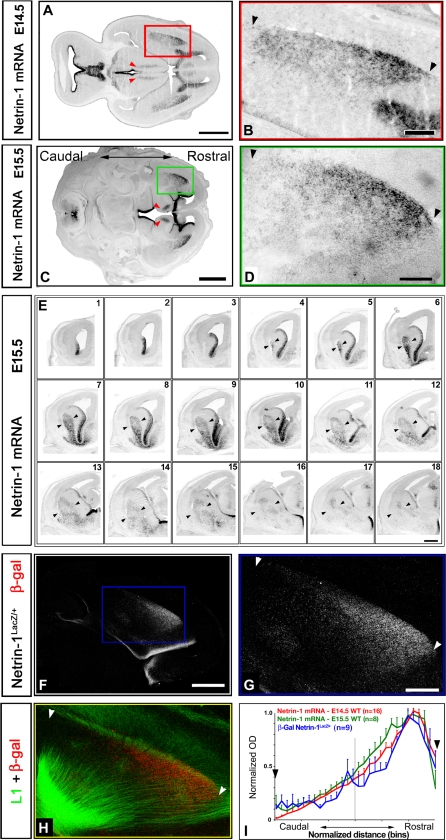
Netrin-1 Is Expressed in a High-Rostral to Low-Caudal Gradient in the Ganglionic Eminence(A–D) mRNA in situ hybridization performed on horizontal sections of E14.5 (A and B) and E15.5 (C and D) mouse embryos reveals that Netrin-1 mRNA is expressed in a high-rostral to low-caudal gradient in the VTel. Also note that Netrin-1 is expressed in the DTh itself (arrowheads in [A] and [C]). (B) shows a higher magnification of the red boxed area in (A); (D) shows a higher magnification of the green boxed area in (C).(E) Series of 18 coronal sections from a single E15.5 wild-type mouse brain showing that the high-rostral to low-caudal gradient of Netrin-1 mRNA expression is found in the mantle region of the ganglionic eminence. Sections are numbered from rostral (#1) to caudal (#18). Arrowheads indicate the location of the internal capsule.(F and G) This rostrocaudal gradient can also be visualized on horizontal sections of a Netrin-1LacZ/+ E15.5 mouse embryo both at low (F) and high (G) magnification on horizontal sections immunostained for β-galactosidase.(H) This high-rostral to low-caudal gradient of Netrin-1 expression coincides spatially with TC axons in the internal capsule in the VTel as visualized by this double immunofluorescence for the cell adhesion molecule L1 (green) and β-galactosidase (red).(I) Quantification of the gradient of Netrin-1 mRNA expression inside the VTel at E14.5 (red), E15.5 (green), and β-galactosidase immunofluorescence in a Netrin-1LacZ/+ E15.5 mouse (blue) using normalized optical density measurement in 30 vertical bins oriented along the rostrocaudal axis on horizontal sections. n indicates the number of sections used to measure the normalized optical density values along the rostrocaudal axis. In (B, D, and G), arrowheads point to the rostrocaudal and dorsoventral width of the internal capsule within the VTel.Scale bars represent in (A) 800 μm; (B) 250 μm; (C) 1 mm; (D) 250 μm; (E) 80 μm; (F) 600 μm; and (G and H) 200 μm.